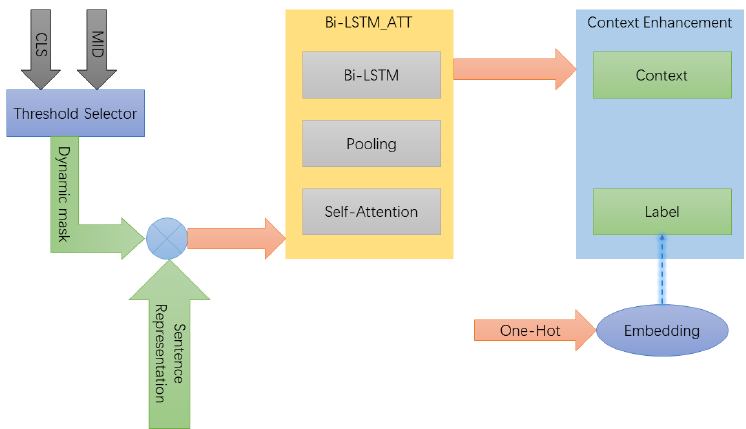
Figure 3. There are three sections in dynamic context module: Threshold Selector, Bi-LSTM_ATT and Context Enhancement. Then, all context are dynamically determined by selector. The Bi-LSTM_ATT is used for improving compatibility. Fusing entity tag is to enhance context representation.